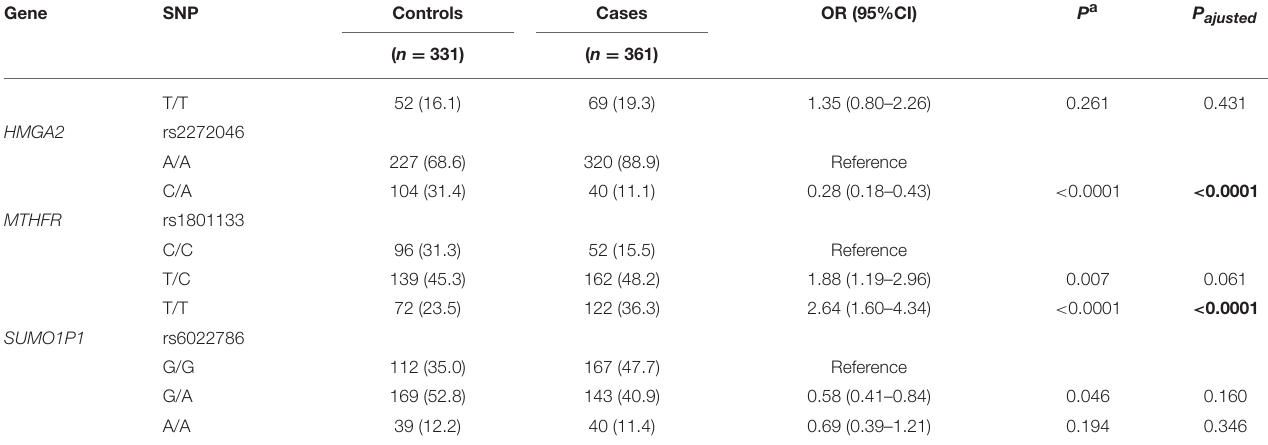
Frontiers in Endocrinology |